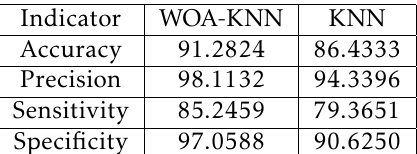
Figure 2. WOA-KNN algorithm. Table 3. the results obtained by WOA -KNN hybrid algorithm for ILPD Data set.